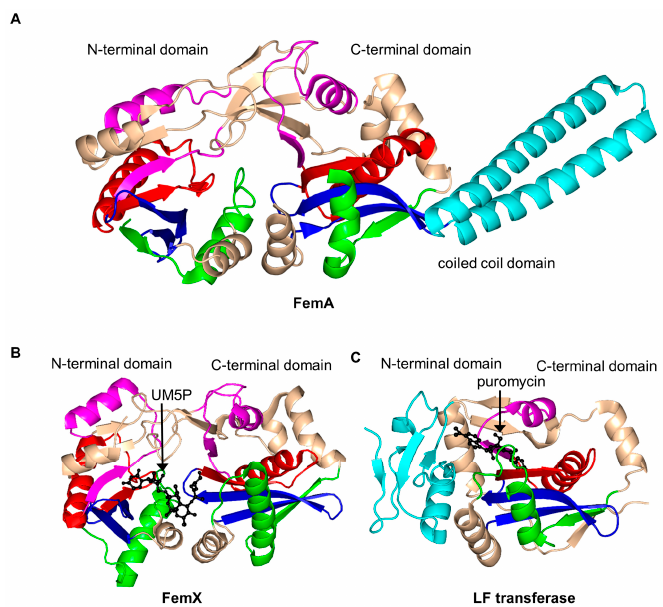
Figure 17. Cartoon representation of the structures of aminoacyl transferases from the FemABX family. ( A ) Staphylococcus aureus FemA apoenzyme (PDB ID: 1LRZ [150]); ( B ) Weissella viridescens